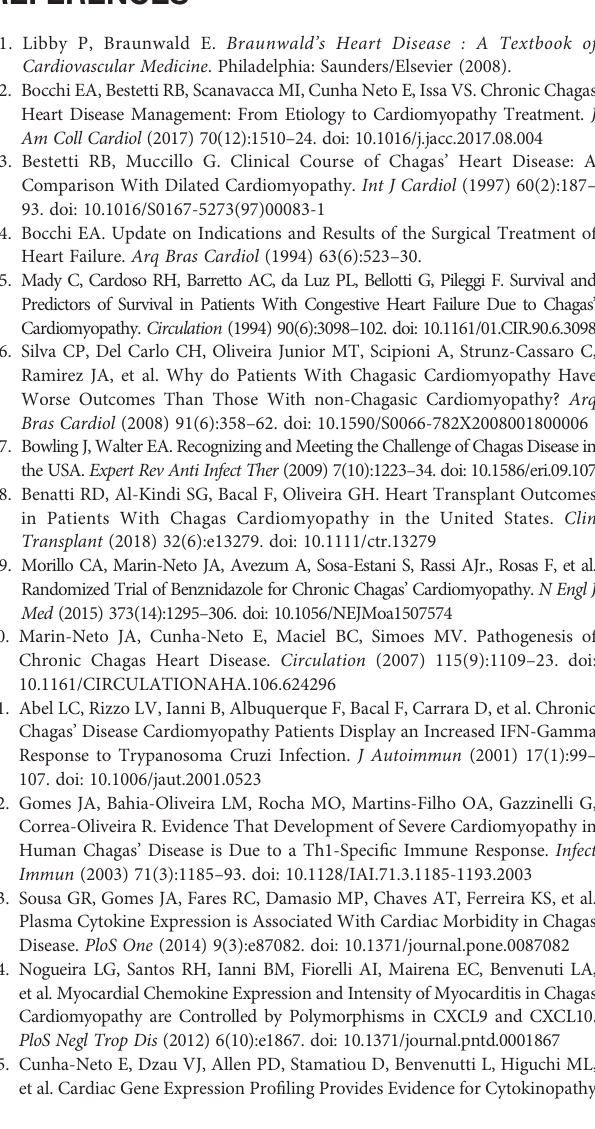
(B) Citric Acid Cycle, (C) Oxidative Phosphorylation, (D) Creatine Kinase System. Arrows indicate up-regulated (red) or down-regulated (green) expression as compared to control myocardial samples in the proteomic analysis. Supplementary Figure 8 | Cartoon depicting sarcomeric related proteins differentially expressed in CCC, DCM and IC myocardium. Arrows indicate up- regulated (red) or down-regulated (green) expression as compared to control myocardial samples in the proteomic analysis. Supplementary Figure 9 | Representative images from Immunoblotting analysis. (A) One-dimensional electrophoresis of the samples used for immunoblotting experiments. SDS-PAGE 12.5%, 30 m g of proteins, gel stained by “ Coomasie Blue Colloidal ” . (B) Representative immunoblotting (Western-blotting) of ACADVL (Very long-chain speci fi c acyl-CoA dehydrogenase), DERC (2,4-dienoyl-CoA reductase 1) and CATA (Catalase) used for densitometry analysis. Relative abundance of a speci fi c protein across the lanes of the blot was given by the normalization to the total amount of protein in each